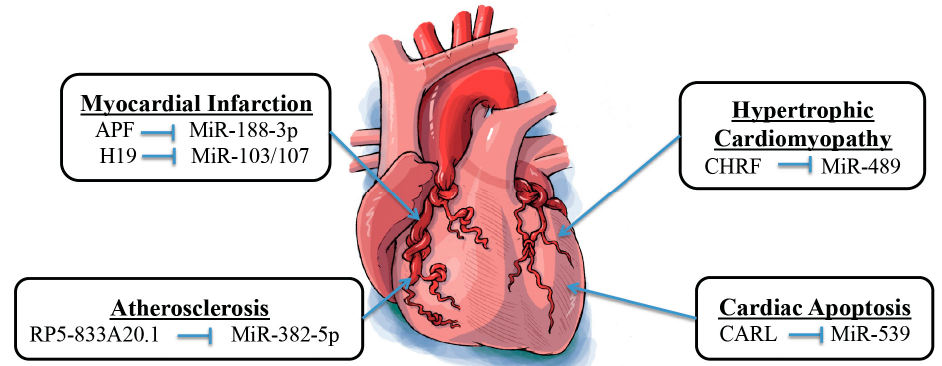
Figure 2. The crosstalk between lncRNAs and miRs in heart diseases.